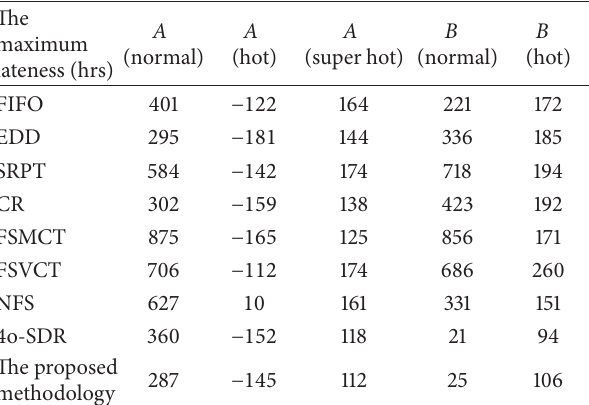
Table 5: The performance levels of various approaches for maxi- mum lateness.